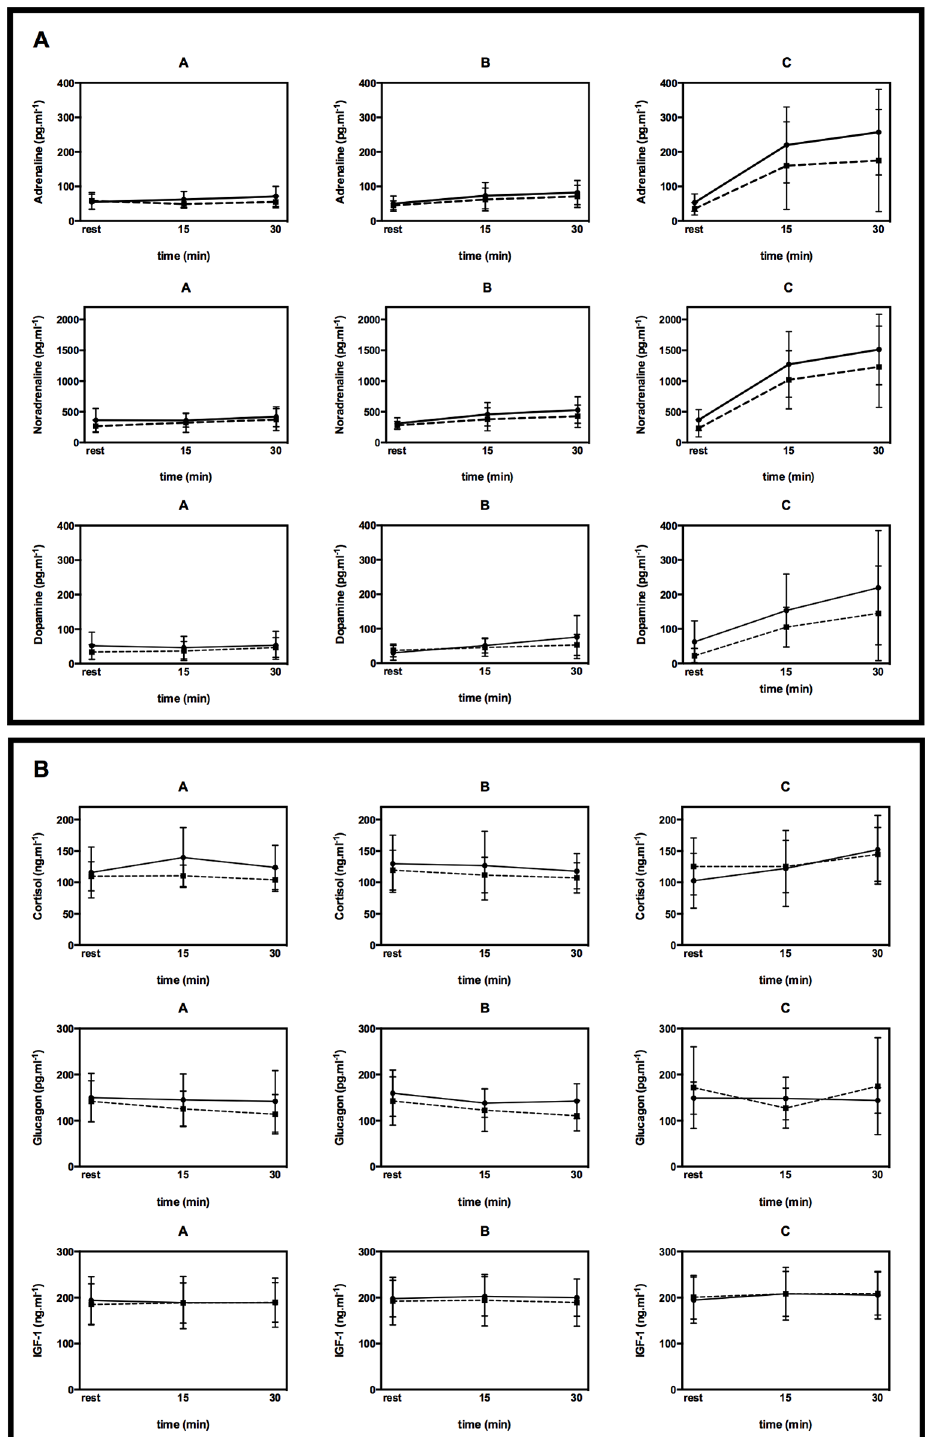
Fig 7. Comparison of hormone response during high-intensity interval exercise (dotted line) vs. continuous exercise (full line) for mean exercise intensities A, B, and C. (A) Catecholamine response. Values are given as mean and SD. (B) Glucagon, cortisol and IGF-1. IGF-1: insulin-like growth factor-1. Values are given as mean and